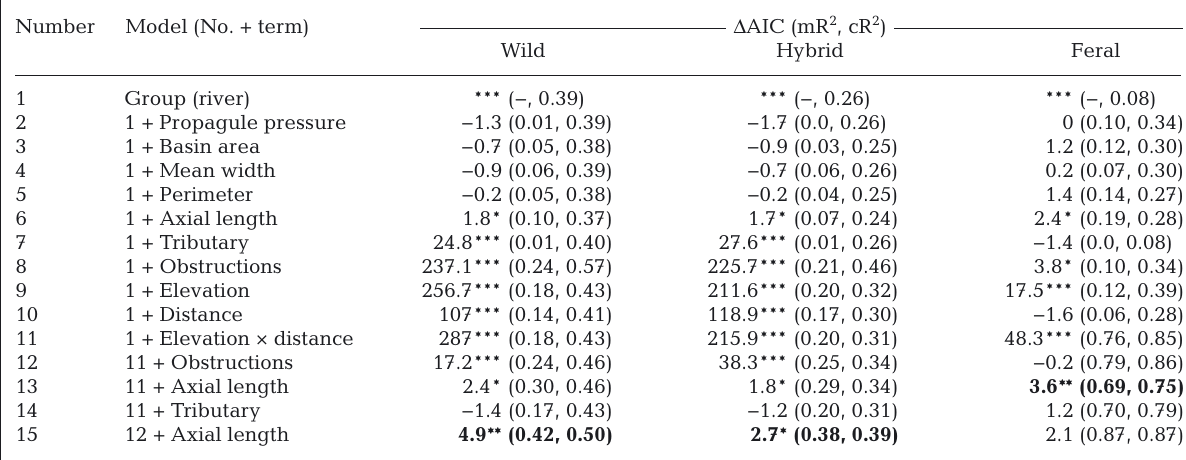
Table 2. Binomial mixed models (model number plus additional terms) and associated change in Akaike’s information criteria ( Δ AIC) from base (numbered) model, with marginal R 2 (mR 2 ) and conditional R 2 (cR 2 ). Asterisks indicate models in which addi- tional parameters were statistically significant. Bold AICs indicate models with best fit (lowest AIC with significant additional term). Age-specific model results can be found in Table S1 in the Supplement at www. int-res. com/ articles/ suppl/ q010